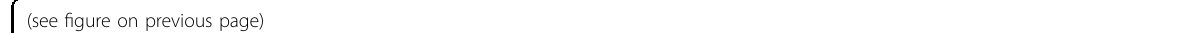
Fig. 1 LncRNA SNHG1 is overexpressed in prostate cancer tissues. A SNHG1 is overexpressed in TCGA PCa data. B , C Survival analysis of SNHG1 (TCGA PRAD) showed that both overall and disease-free survival were worse in the highly expressed group. D FISH analysis of PCa tissues con fi rmed that SNHG1 was highly expressed in PCa tissues and located in the nucleus (G means Gleason grade group). E SNHG1 expression was analyzed by qRT-PCR in fi ve PCa cancer cell lines (DU145, PC-3, 22RV1, LNCaP, and C4-2), compared with the human Prostatic immortalized epithelial cells (RWPE- 1). F Distribution of SNHG1 in PCa cells detected by fractionation of DU145 and C4-2 cells followed by qRT-PCR. G FISH analysis of DU145 cell. The nuclei were stained with DAPI and 18 S was used as a positive control for cytoplasmic staining. GS means Gleason Score. Scale bar, 20 μ m. All data are shown as the mean ± SD. * P < 0.05, ** P < 0.01, *** P < 0.001 and **** P < 0.0001 by two-tailed Student ’ s t test.